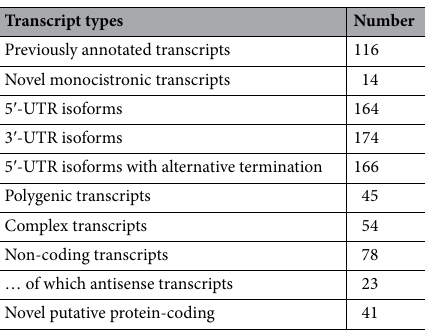
Table 2. The number of previously annotated and novel transcripts of